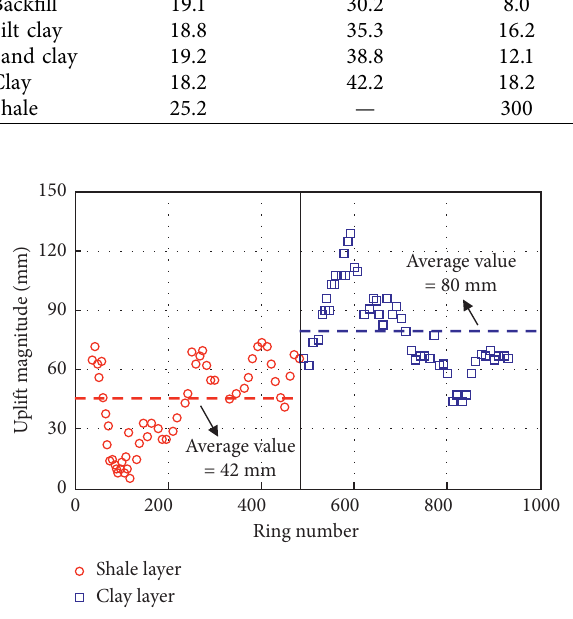
Figure 2: Segment uplift of the tunnel from the 30 th to the 930 th ring passing through two different layers.